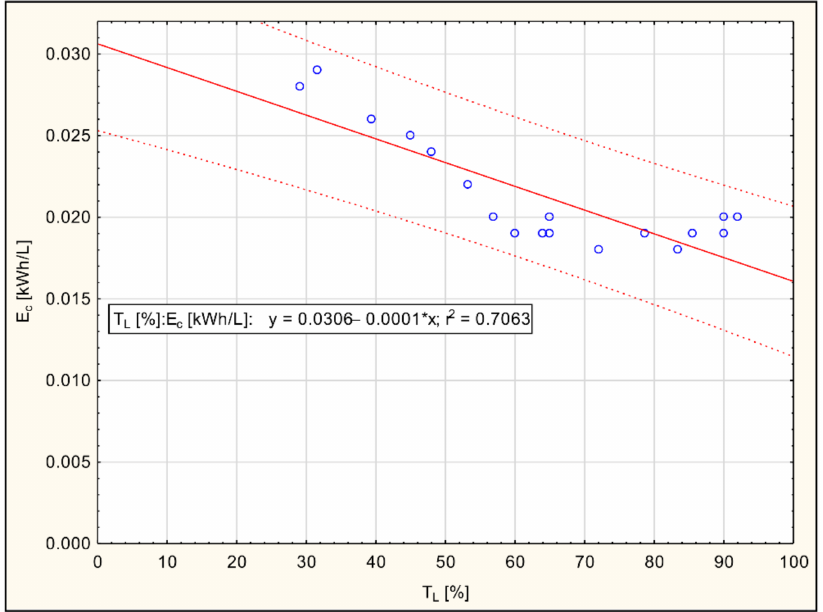
Figure 5. Changes in energy consumption (E c ) in the cow milking process with an increase in the technological index level (T L